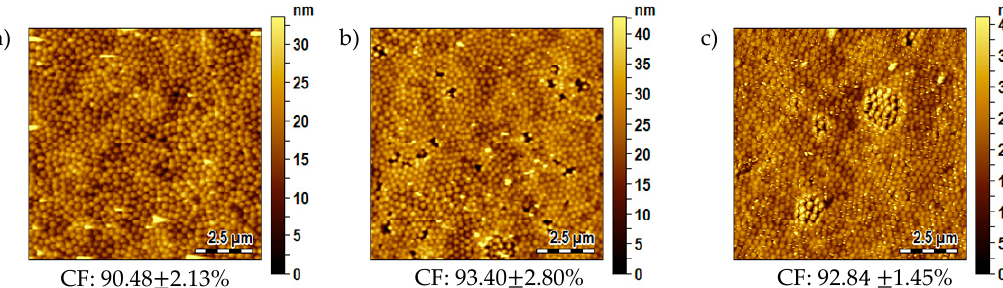
Figure 4. AFM images of the MGs film realized onto the gold coated fiber tip with different dipping time and speed. ( a ) 1 min (at 5 mm/min), ( b ) 0.05 min (at 100 mm/min), ( c ) 0.025 min (at 200 mm/min).